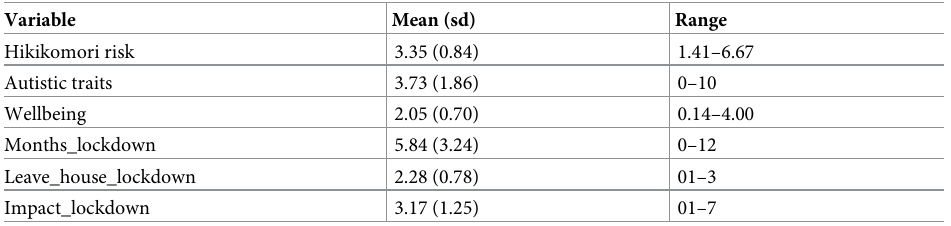
Table 1. Distributions of the study variables.